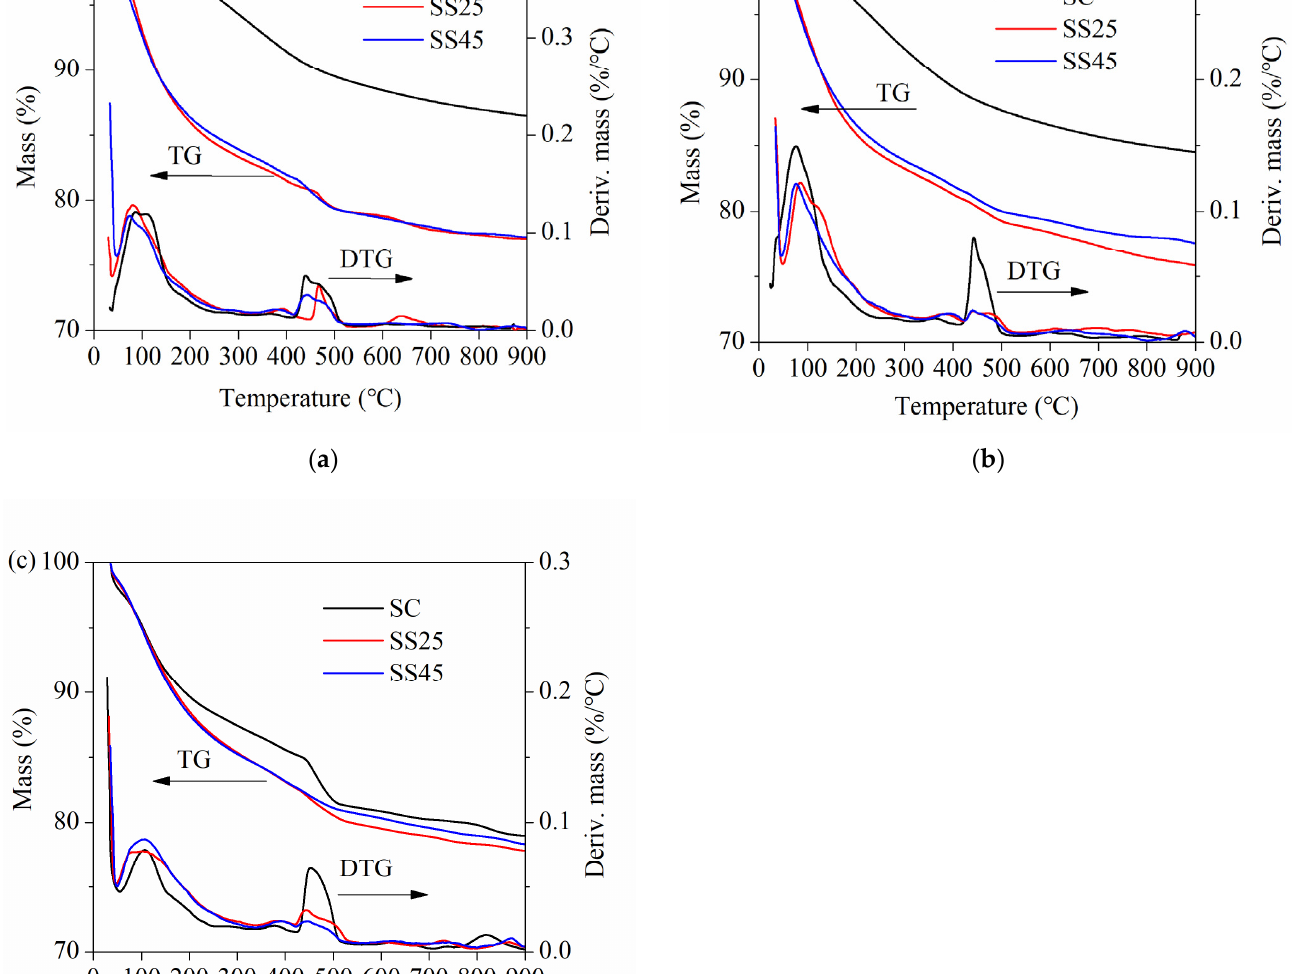
curing conditions: ( a ) at 14 d; ( b ) at 28 d; ( c ) at 90 d.